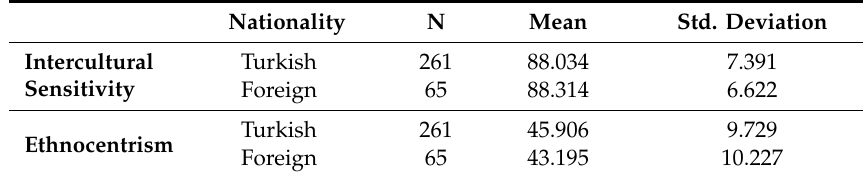
Table 9. Mean and standard deviation of students’ scores by nationality in the Intercultural Sensitivity Scale and the Ethnocentrism Scale. N Mean Std.